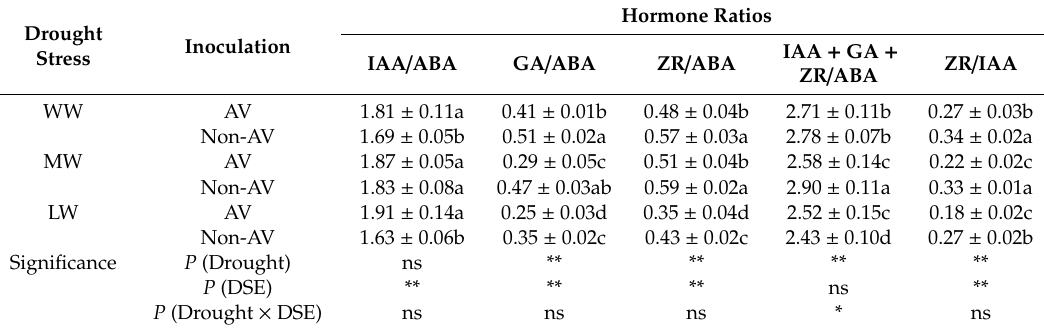
Figure 5. E ff ects of A. vagum on IAA ( a ), ABA ( b ), GA ( c ), and ZR ( d ) of O. hosiei seedlings under drought stress conditions. Treatments: Non-AV, non- A. vagum ; AV, A. vagum ; WW, well watered; MW, moderate water; LW, low water. Thick bars represent the means and thin bars represent standard errors for n = 5. Di ff erent letters indicate group with significant di ff erences for p < 0.05. Table 2. Root phytohormone ratios of O. hosiei seedlings inoculated with A. vagum , a dark septate endophyte, and grown under di ff erent levels of drought